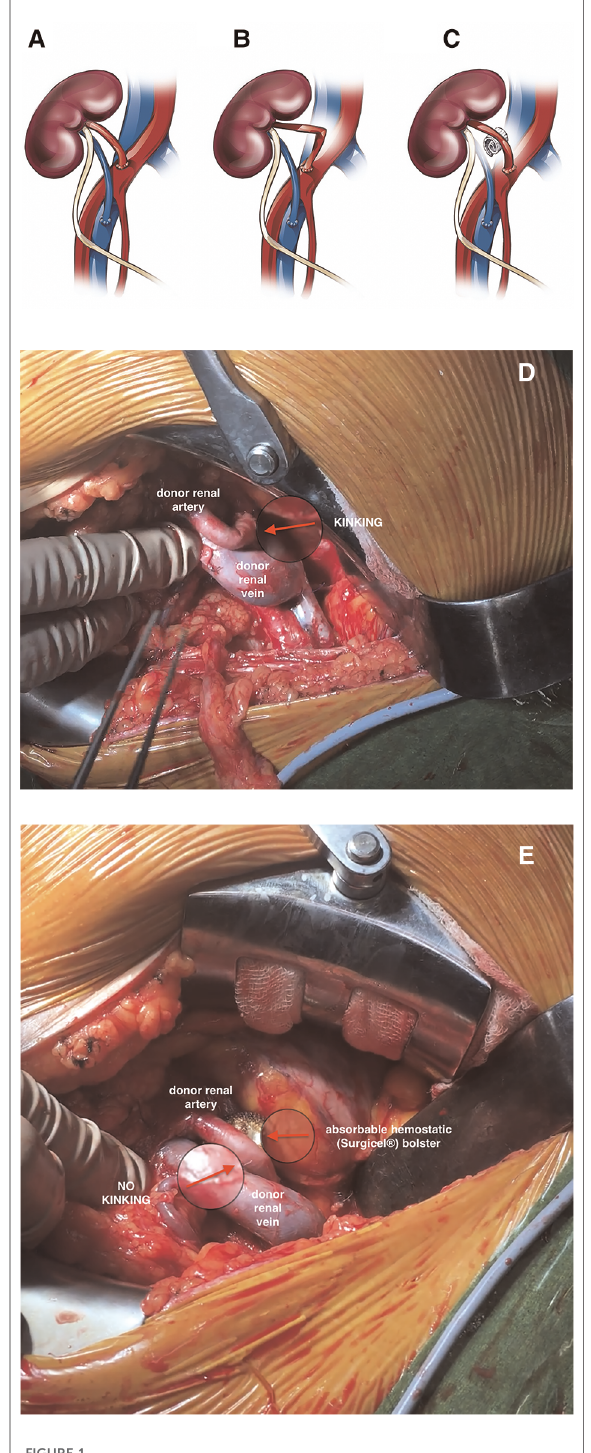
FIGURE 1 Schematic and real-life presentation of the use of an absorbable hemostatic pad to prevent kinking of the donor renal artery in kidney transplantation: normal anatomy ( A ), kinking of the donor renal artery ( B,D ), and an absorbable hemostatic bolster supporting the middle third of the kinked donor renal artery ( C,E